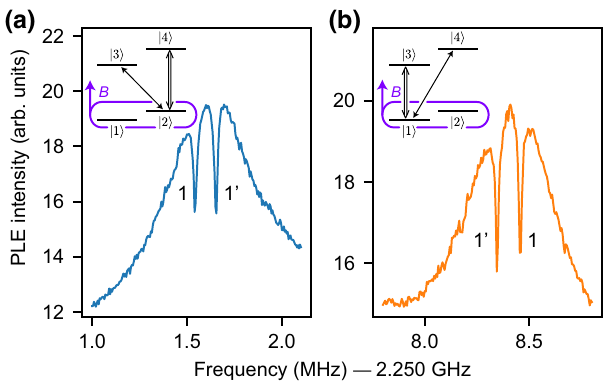
FIG. 4. ODMR spectra with optical readout via TX 0 B 1 . In this configuration, CPT is possible in each of the two V schemes, insets in (a),(b) alongside the corresponding data. Coherences are prepared in the electron spin state opposite that in Fig.